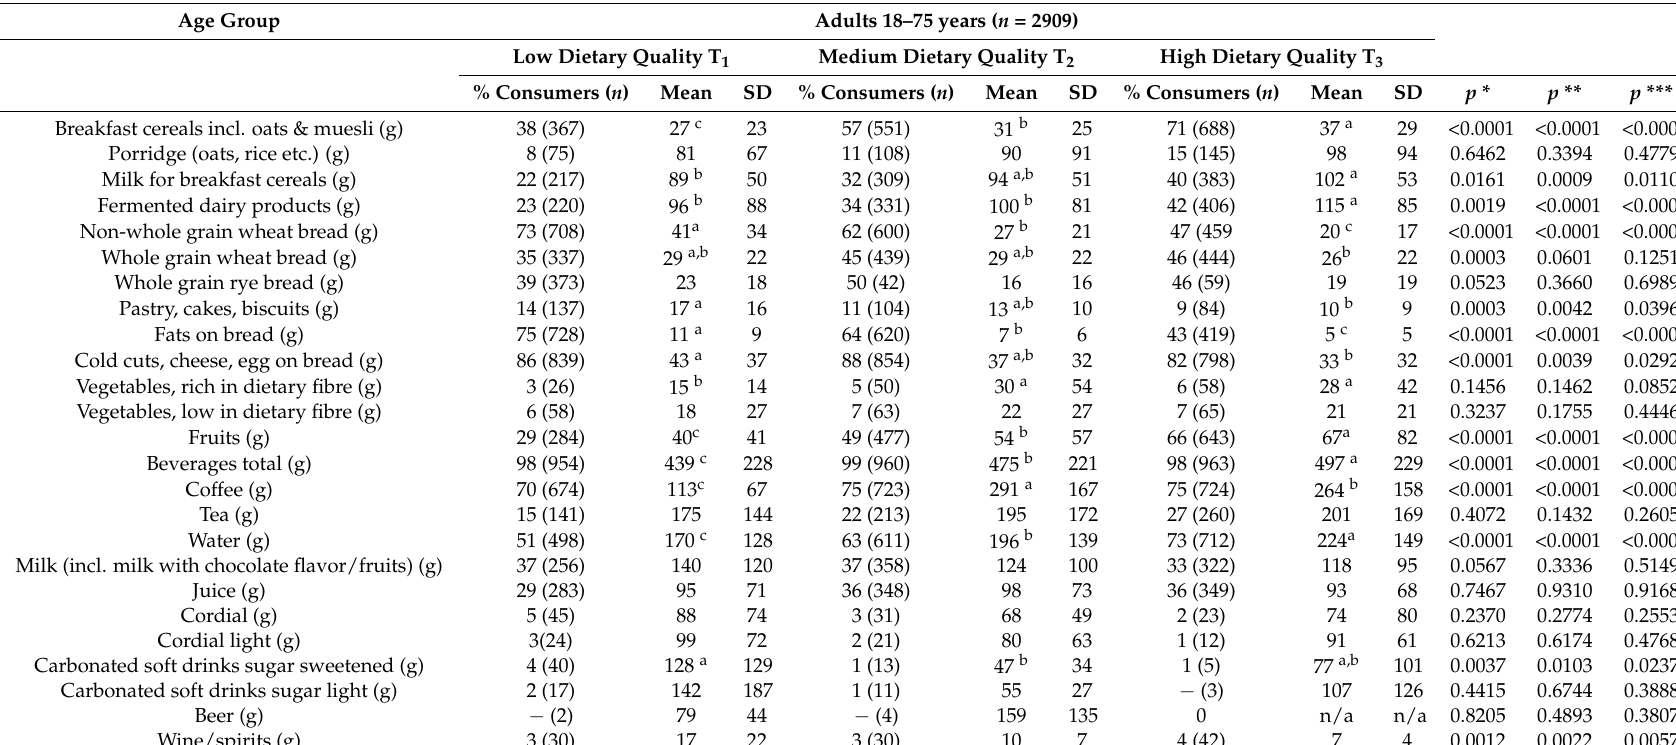
Table 7. The mean intake at breakfast of selected food groups (eaters only) among breakfast consumers across the tertiles of the NRF 9.3 score among Danish